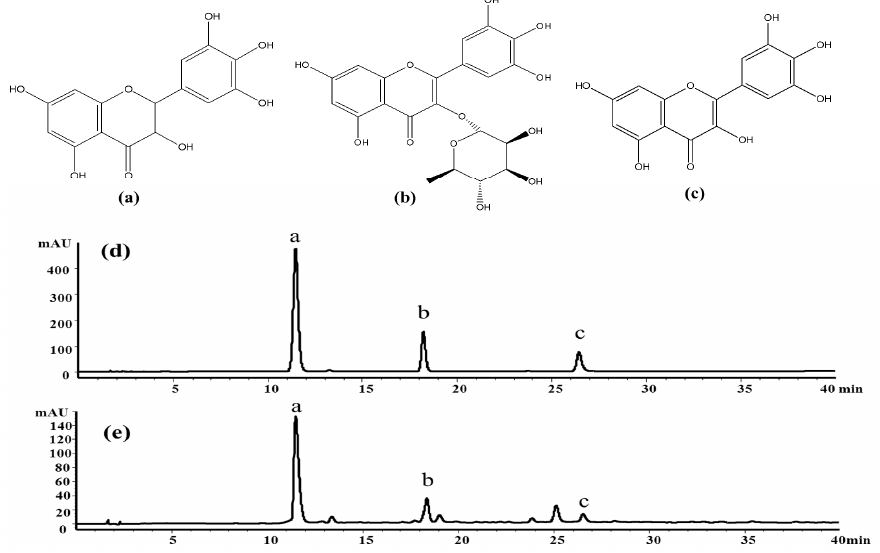
Figure 1. Chemical structures of dihydromyricetin ( a ), myricitrin ( b ), myricetin ( c ) and the typical chromatograms of the standard mixture solution ( d ); and a sample extract obtained by ultrasonic-assisted extraction (UAE) ( e ). The chromatograms were acquired by a high performance liquid chromatography instrument equipped with a diode-array detector at 292